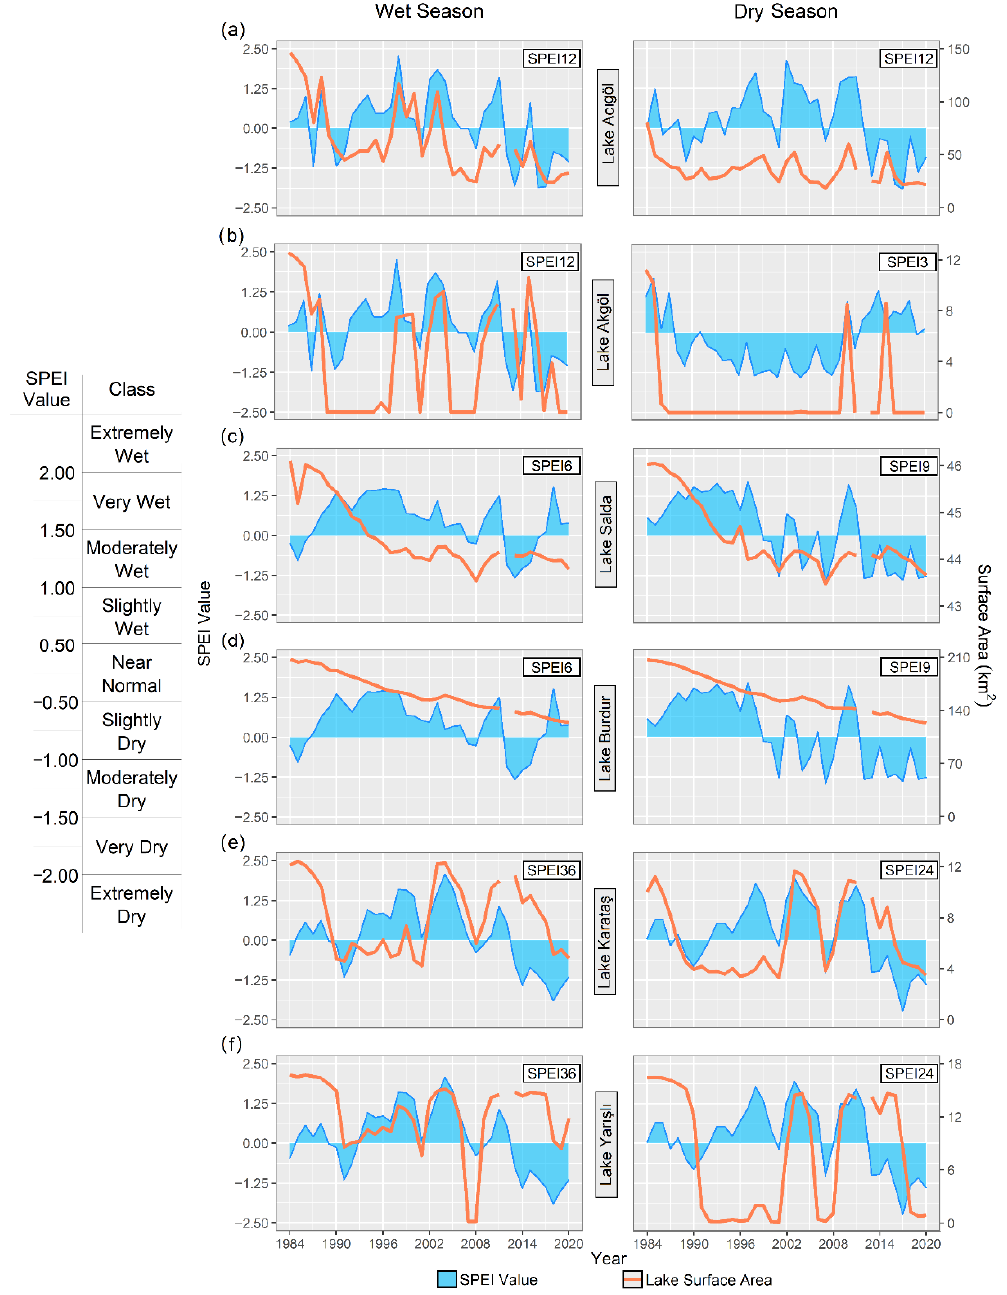
Figure 5. SPEI moisture categories (left) and SPEI and lake surface areas in wet and dry seasons for the period 1984–2020 for lakes ( a ) Ac ı göl, ( b ) Akgöl, ( c ) Salda, ( d ) Burdur, ( e ) Karata ş , and ( f ) Yar ı ş l ı .